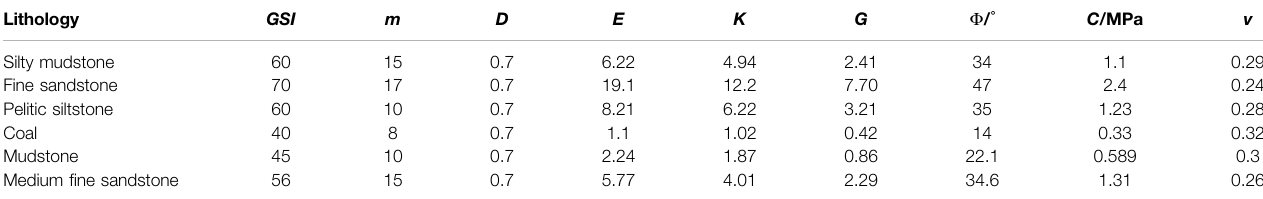
TABLE 3 | Rock mass mechanical properties used in numerical simulation.